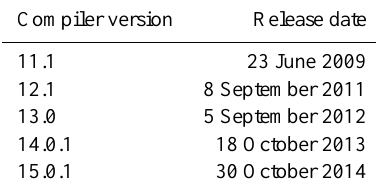
Table 2. Five latest versions of the Intel